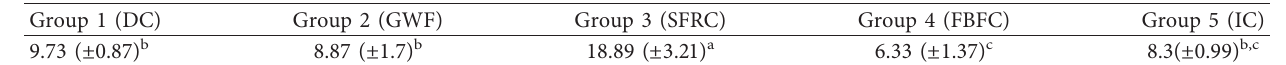
Table 4: Elasticity of modulus values (GPa) and standard